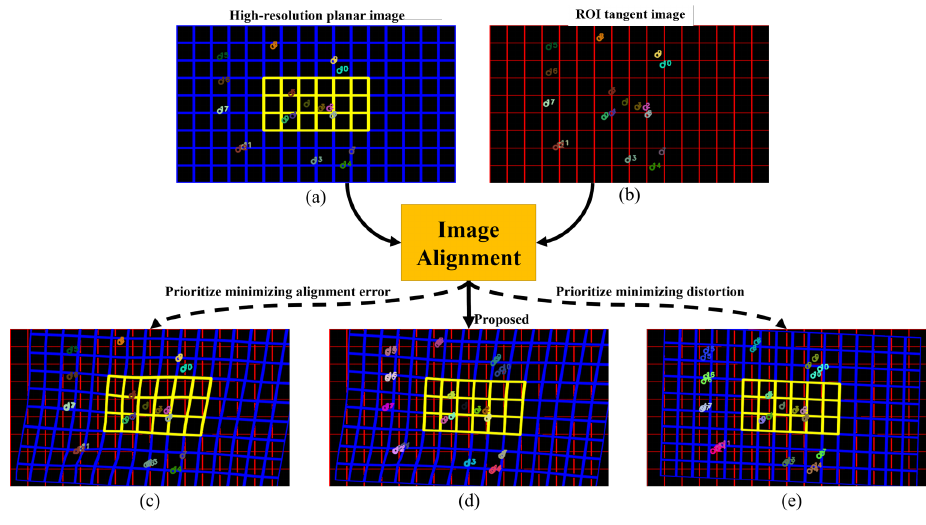
Figure 8. Alignment-Distortion Error Tradeoff Illustration. The figures depict image grid represen- tation of ( a ) high-resolution planar image (HPI) and ( b ) ROI tangent image (ROI-TI). The features are shown as numbered bullets inside each image. The same feature number on both HPI and ROI-TI indicates a matching pair. ( c , e ) showed the possible scenario when we prioritize minimizing alignment error of the feature pairs or keeping the central region object shape, respectively. We propose figure ( d ), which is in an agreement between both